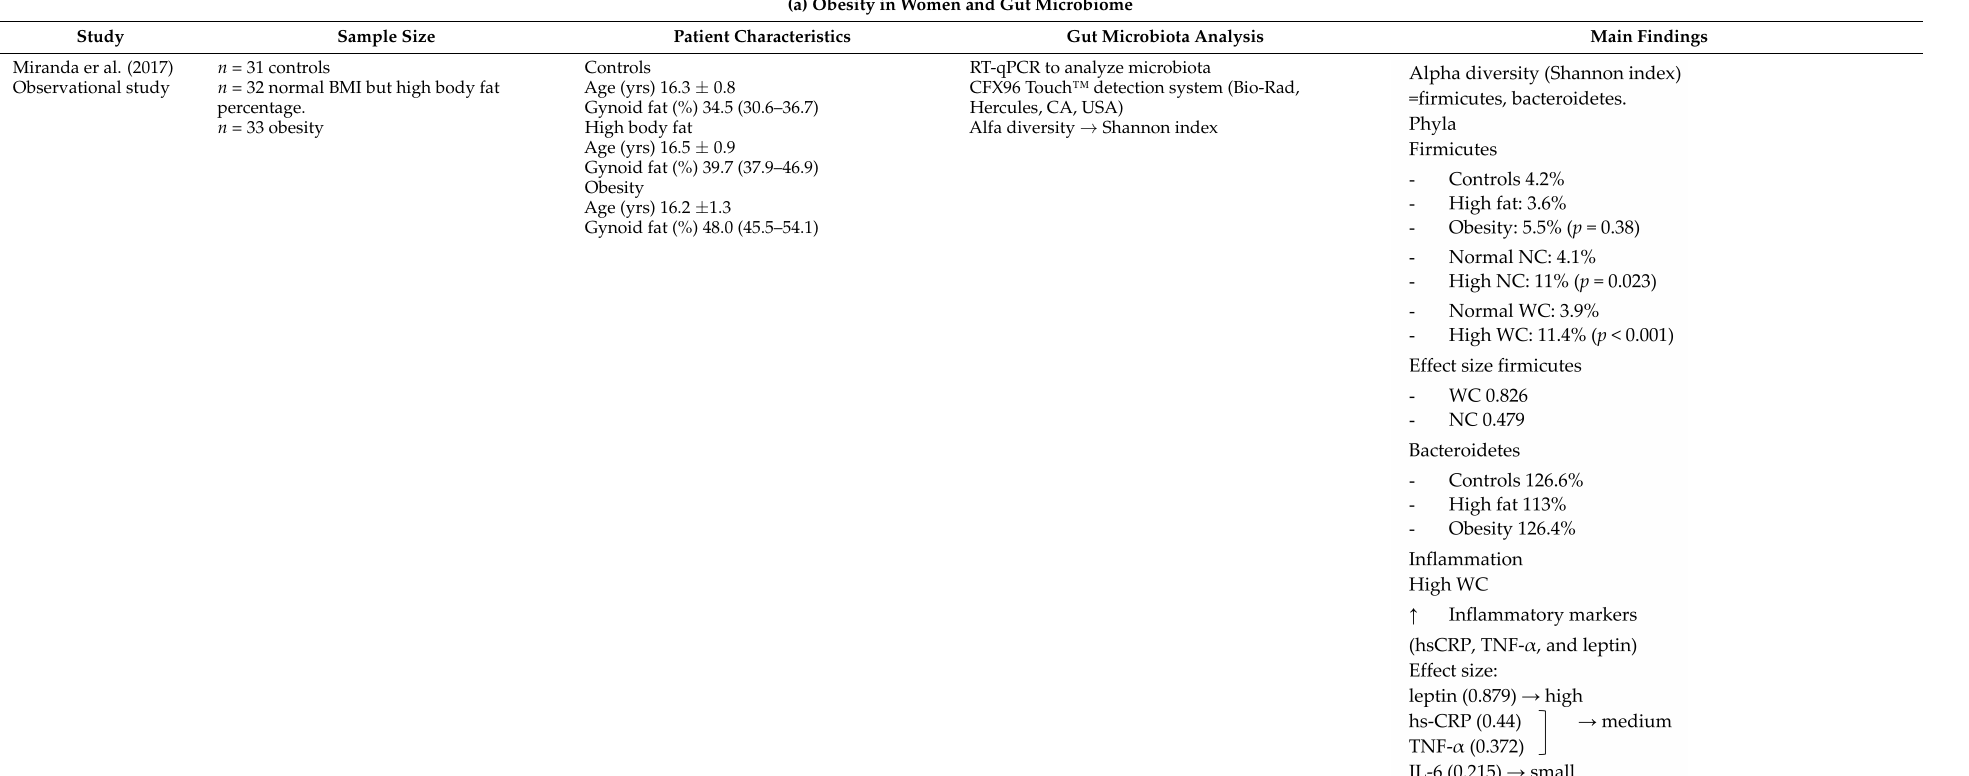
(a) Obesity in Women and Gut